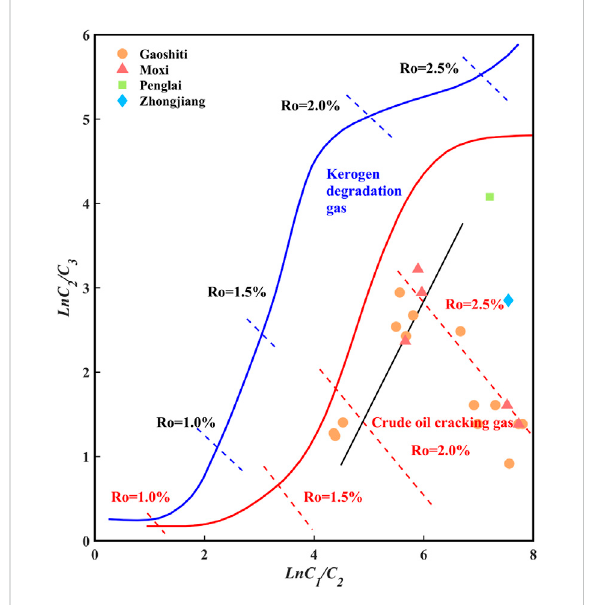
FIGURE 3 Discrimination plot demonstrating the natural gas genesis andmaturitybasedontheidenti fi cationchart createdby(Xieetal.,